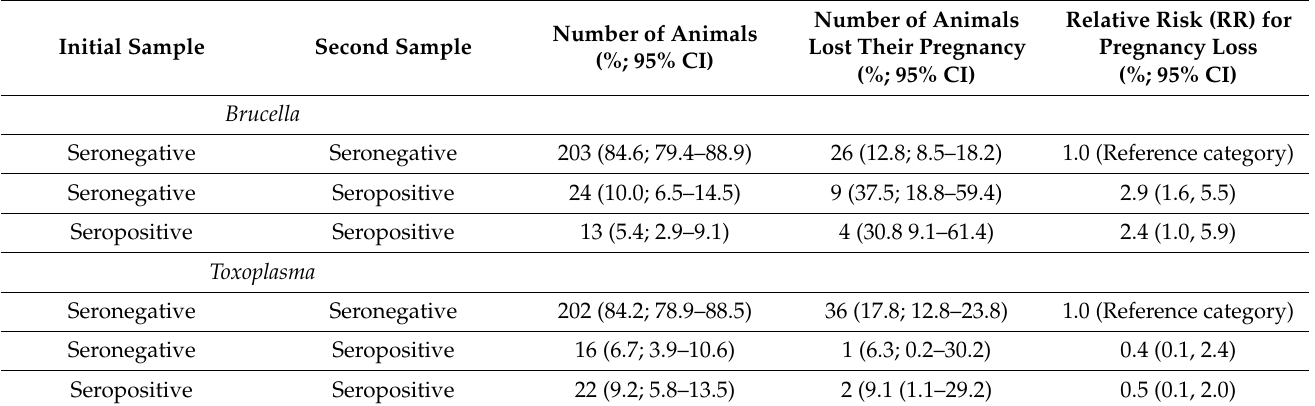
Table 1. Serological response to Brucella and Toxoplasma in 240 pregnant sheep and goats at two sampling points and the effect on pregnancy